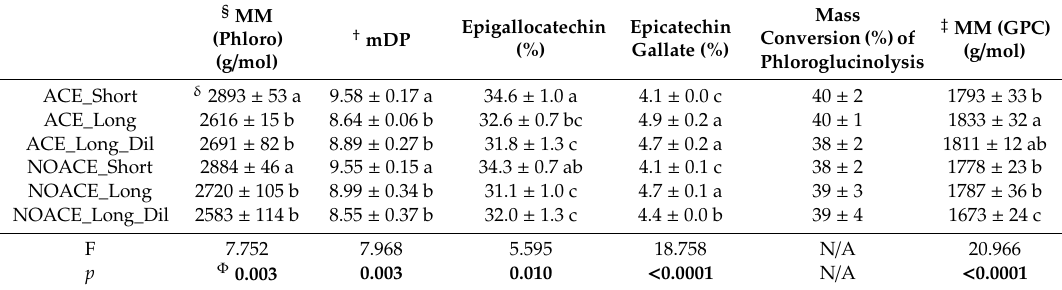
Table 3. The tannin composition of Shiraz wines prepared following the NOACE and ACE maceration with either 3 days (Short) or 6 days (Long) on skins, or 6 days on skins with pre-fermentation water dilution to 13.5 B é (Long_Dil). § MM Mass Epicatechin † mDP Epigallocatechin Conversion(%)of (Phloro) (%) Gallate (%) (g / mol)